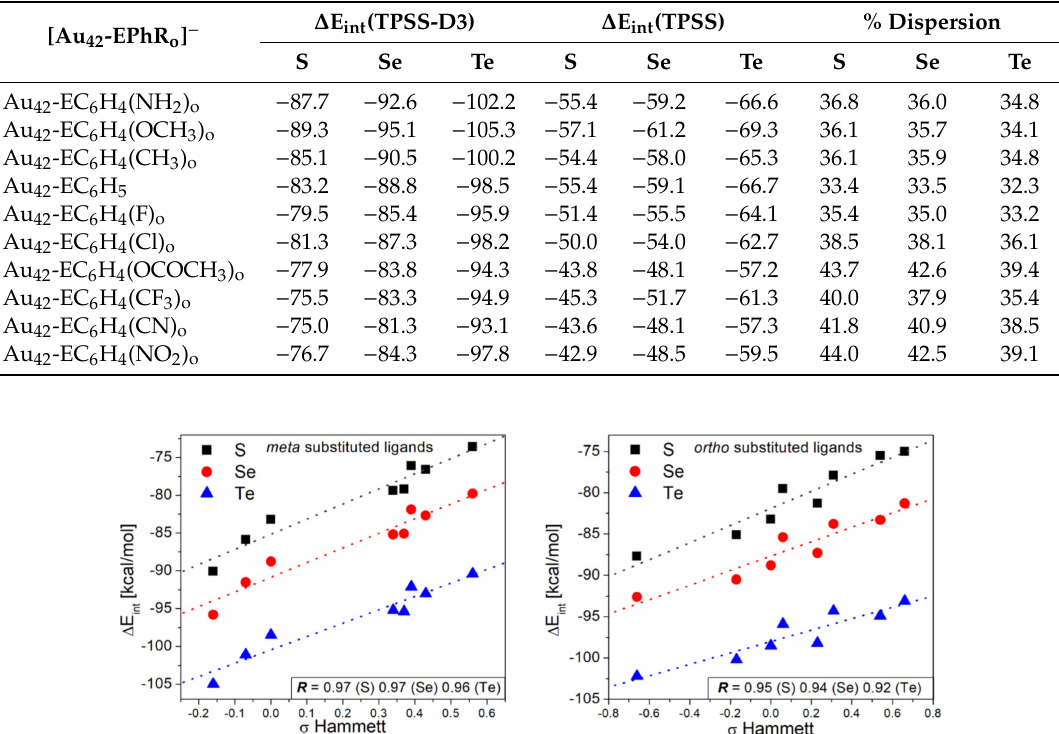
Table 1. Interaction energies between Au 42 and ortho substituted chalcogen (E = S, Se, Te). The energies listed correspond to the total interaction energies ( ∆ E int (TPSS-D3)) and without the dispersion contribution ( ∆ E int (TPSS)). The percentage of dispersion term is included. All energies are in kcal / mol.